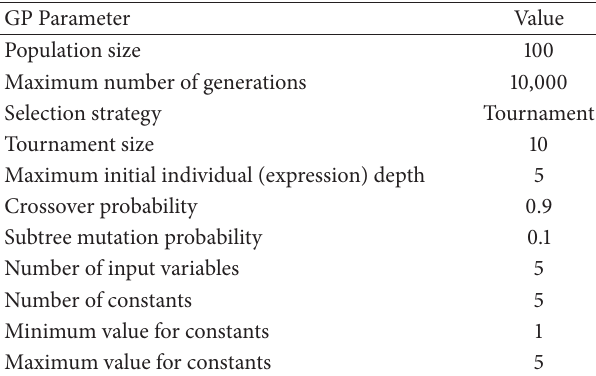
Figure 10: GP zinc expression no. 4. Table 3: The GP parameters used in the experiments.